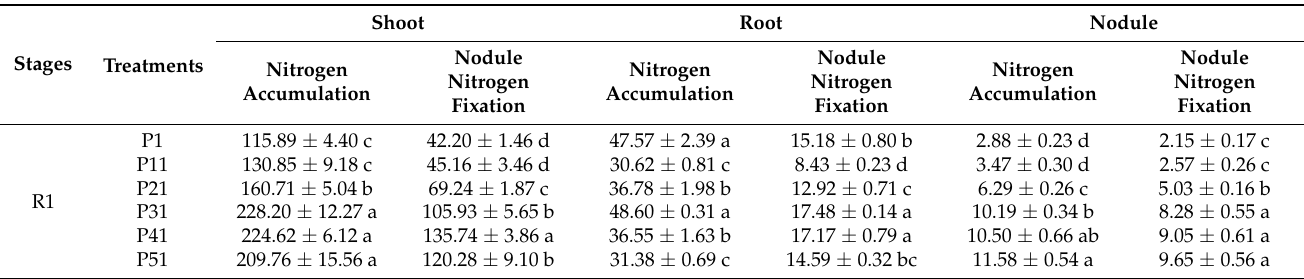
Table 5. Nitrogen accumulation and nodule nitrogen fixation in different parts of soybean under different phosphorus supply levels